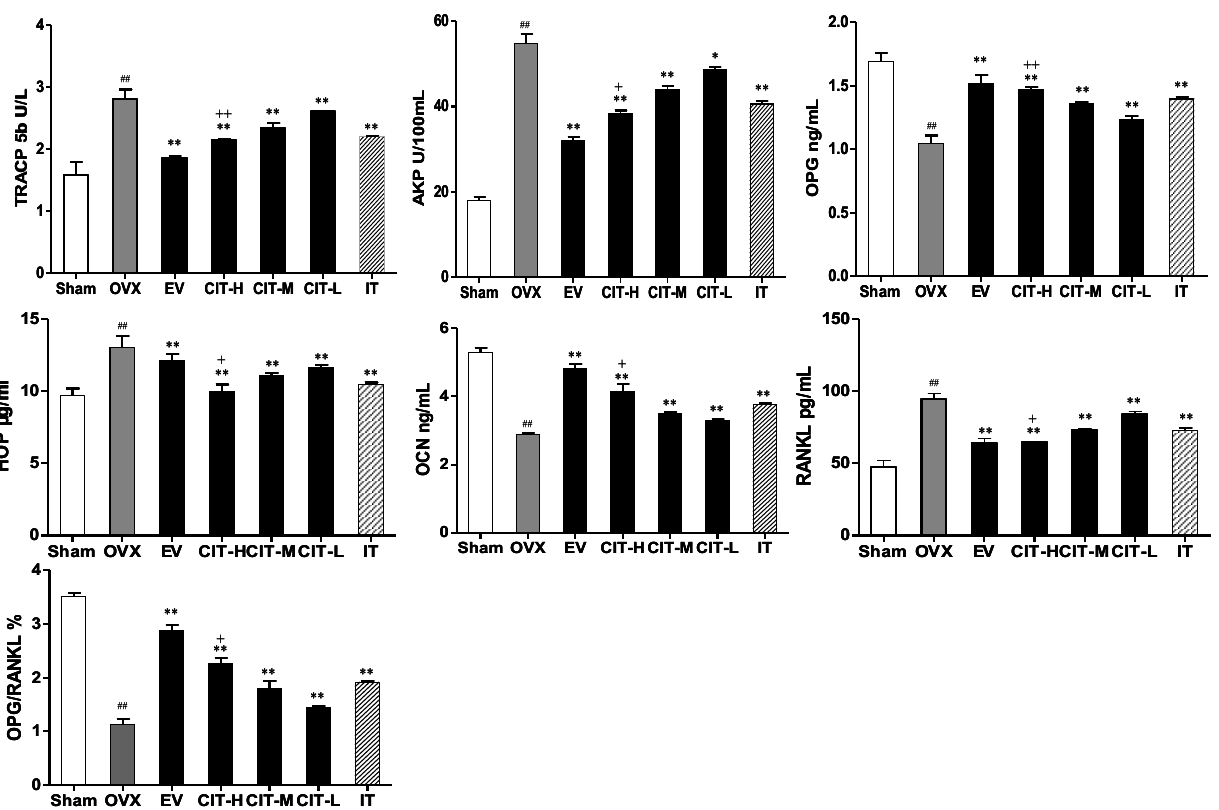
Figure 3. Serum parameters changes in the OVX model of osteoporosis. OVX rats received vehicle (OVX), EV (100 μg/kg/day), CIT (10, 20 and 40 mg/kg/day), and IT (40 mg/kg/day) for 12 weeks. Values are mean ± SD, error bars in the figures were presented as SD, n = 8. ## p < 0.01 compared with sham, ** p < 0.01 compared with OVX, + p < 0.05 compared with IT, ++ p < 0.01 compared with